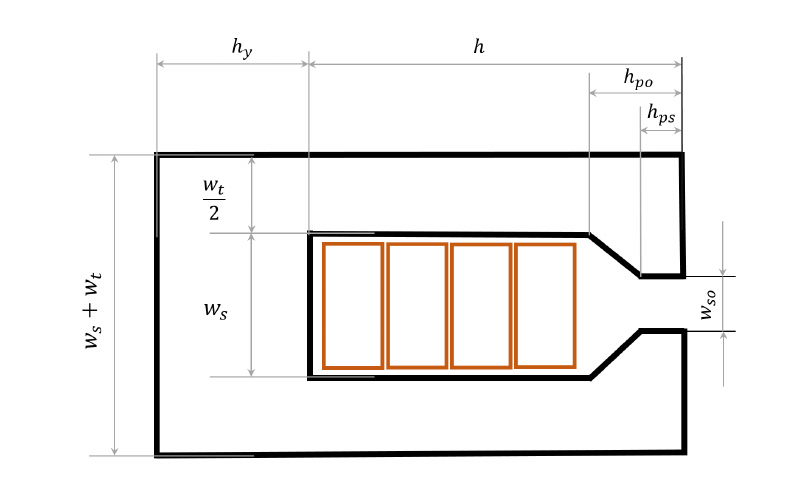
Figure 6. Stator slot parameters.